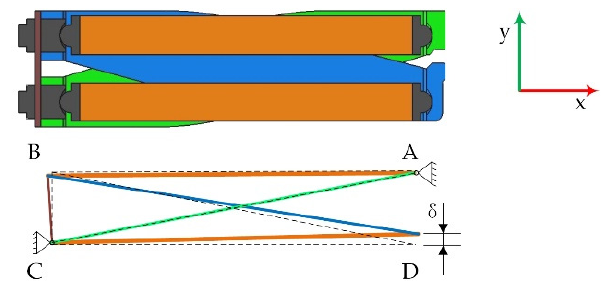
Figure 2. X module and its truss model.